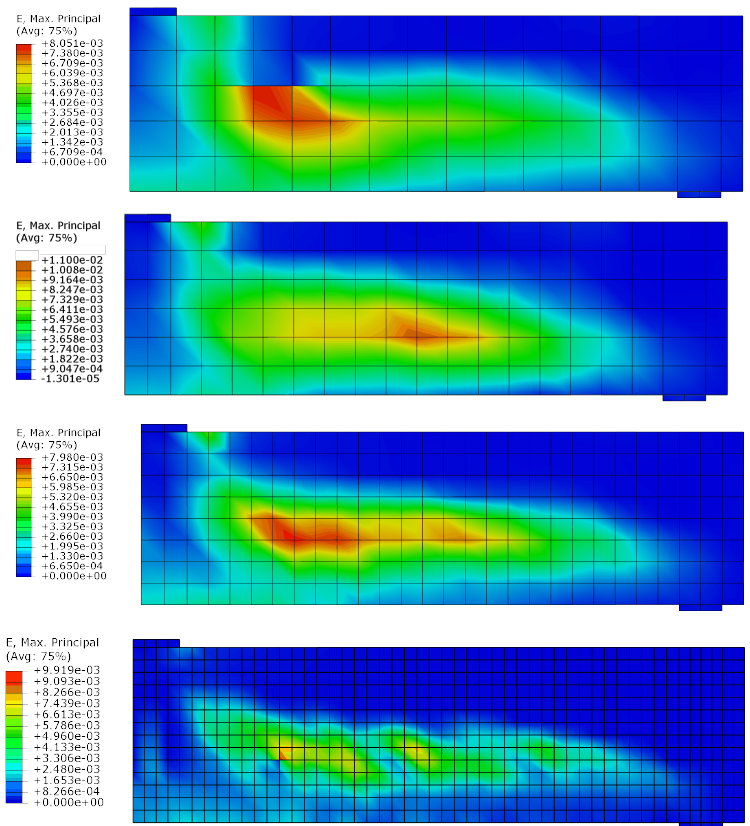
Figure 29. A-1 beam failure in shear—maps of maximum principal